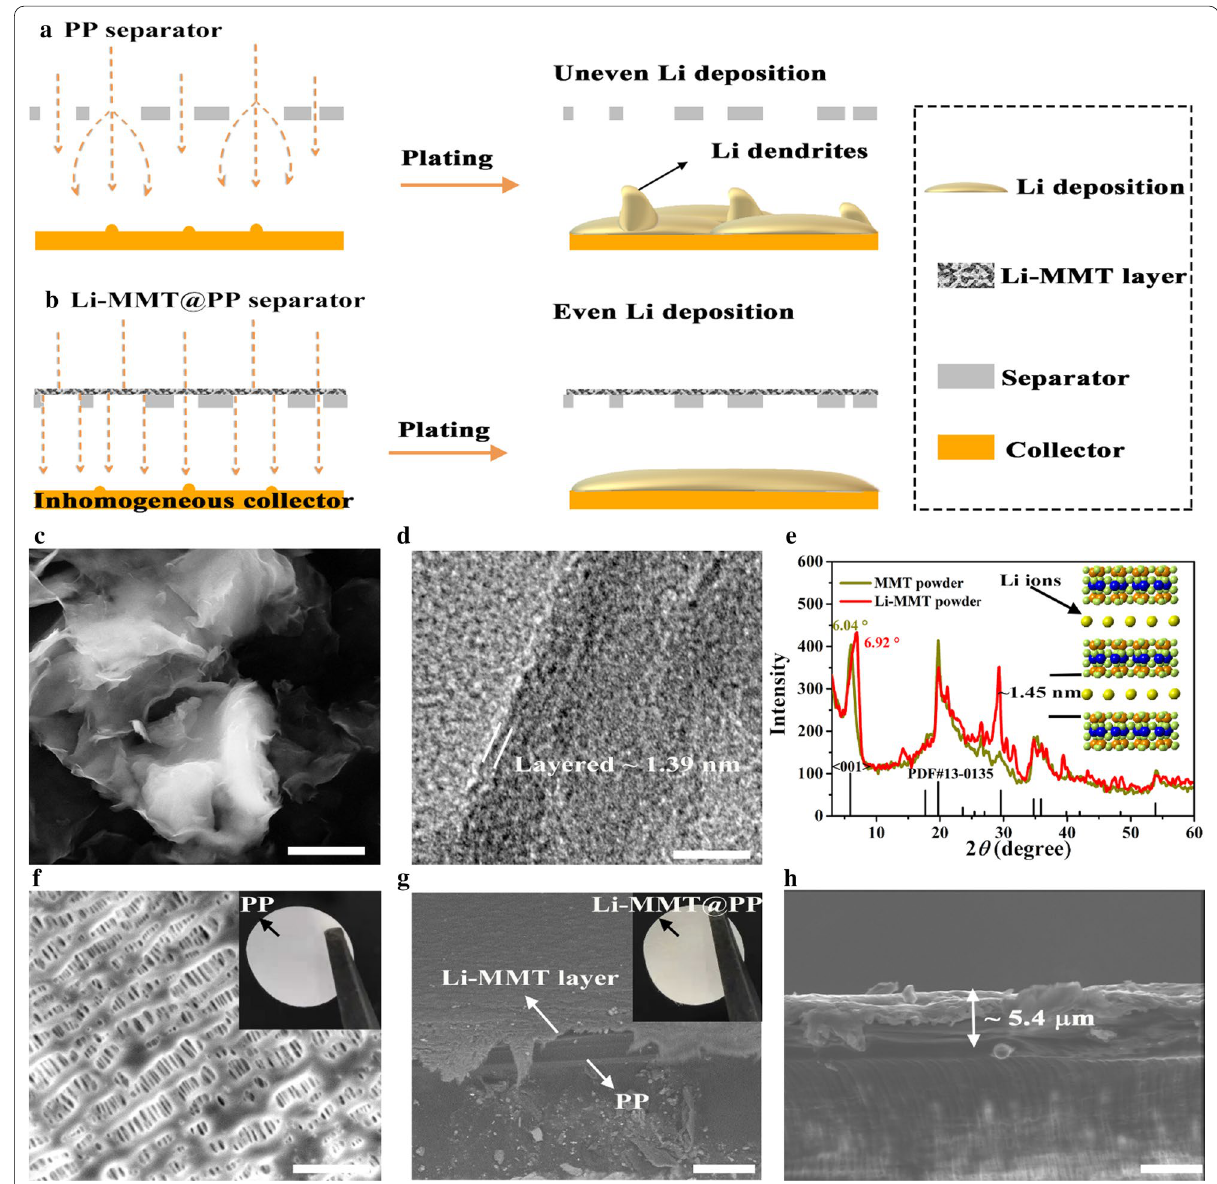
Fig. 1 Preparation and characterizations of Li-MMT powders and Li-MMT@PP separator. a , b Schematics of design concepts with different separators. c SEM image of Li-MMT. d HRTEM image of Li-MMT. e XRD spectrum. f SEM image of PP separator, the inserted optical image is PP separator. g SEM image of Li-MMT@PP separator and h corresponding cross profile, the inserted optical image in g is Li-MMT@PP separator. Scar bar: c 1.5 µm, d 5 nm, f 2.5 µm, g 25 µm, h 5